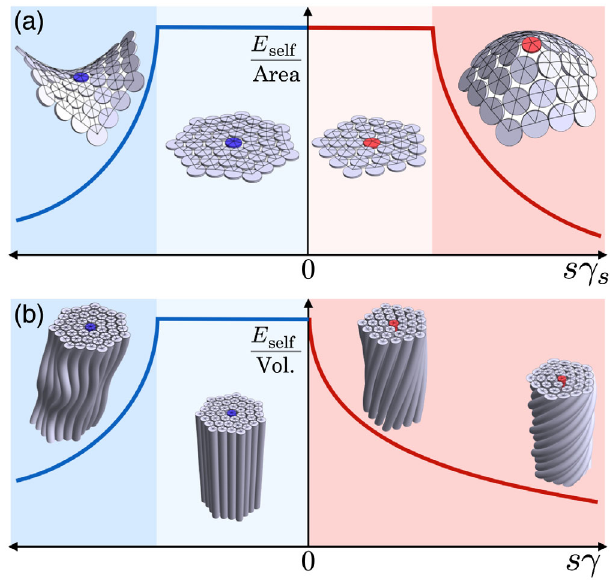
FIG. 10. (a) Self-energy of a single defect versus the disclina- tion charge and FvK number, showing only a minor asymmetry in the threshold γ s for buckling. (b) Self-energy of a single defect versus the disclination charge and fil-vK